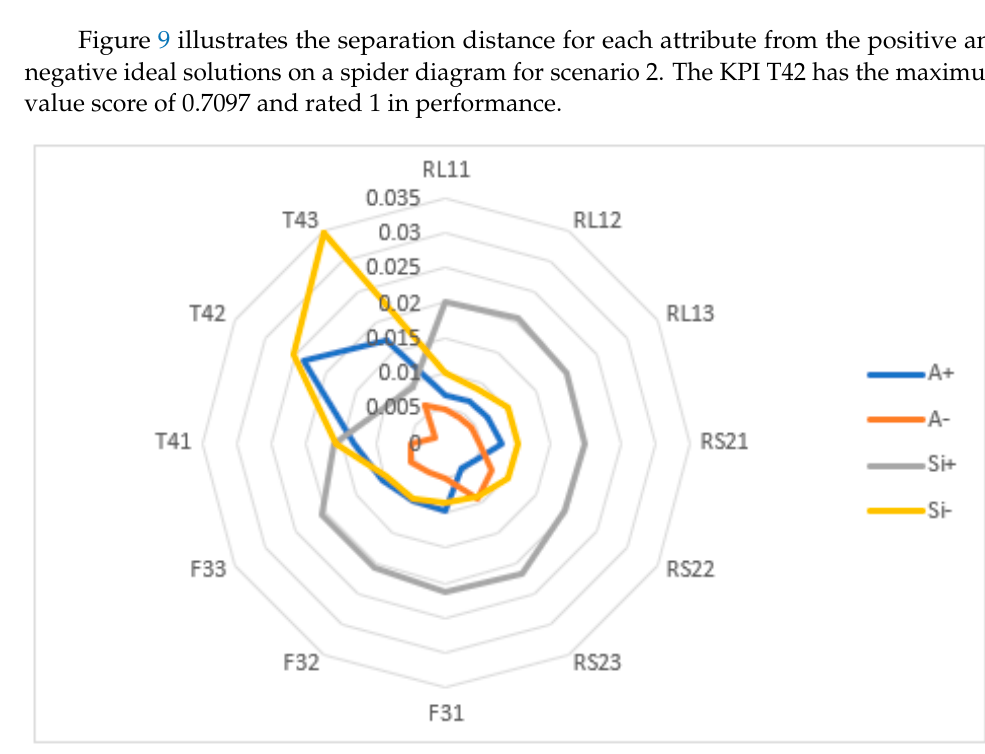
Figure 9. Separation from positive and negative ideal solutions for scenario 2 KPIs.